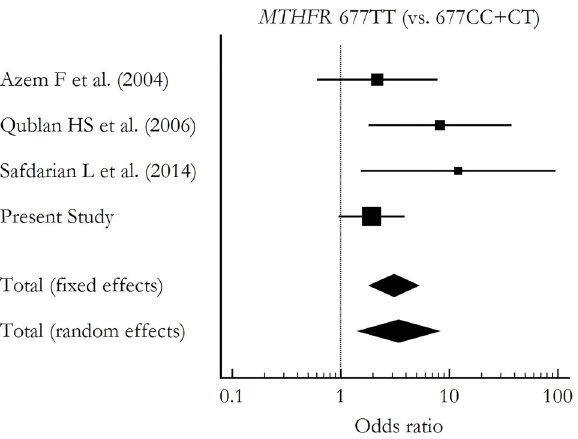
Fig 1. A meta-analysis of MTHFR 677C > T in RIF. A meta-analysis of the association between carriers of the T allele (individuals with TT genotype) in the MTHFR 677C > T polymorphism and recurrent implantation failure (RIF). The fixed and random effects models were used to calculate the pooled weighted odds ratios